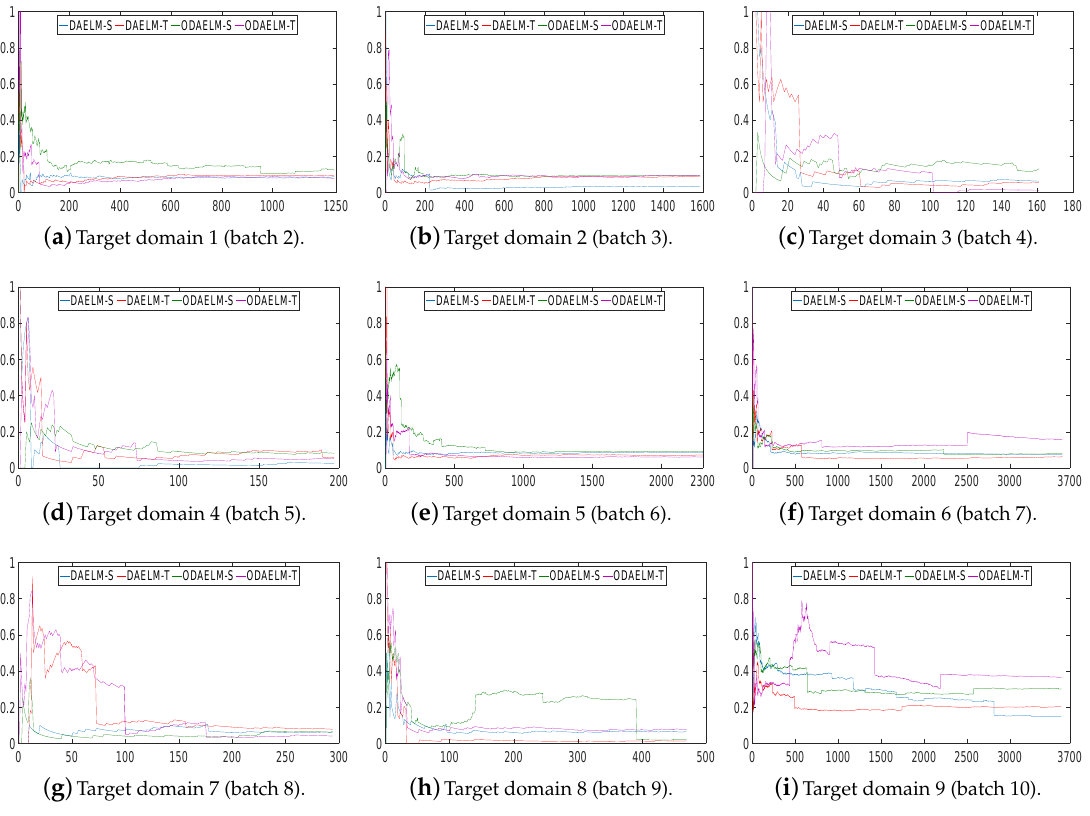
Figure 9. Classification errors on nine target domains using setting 2. The x - and y -axes are the same as Figure